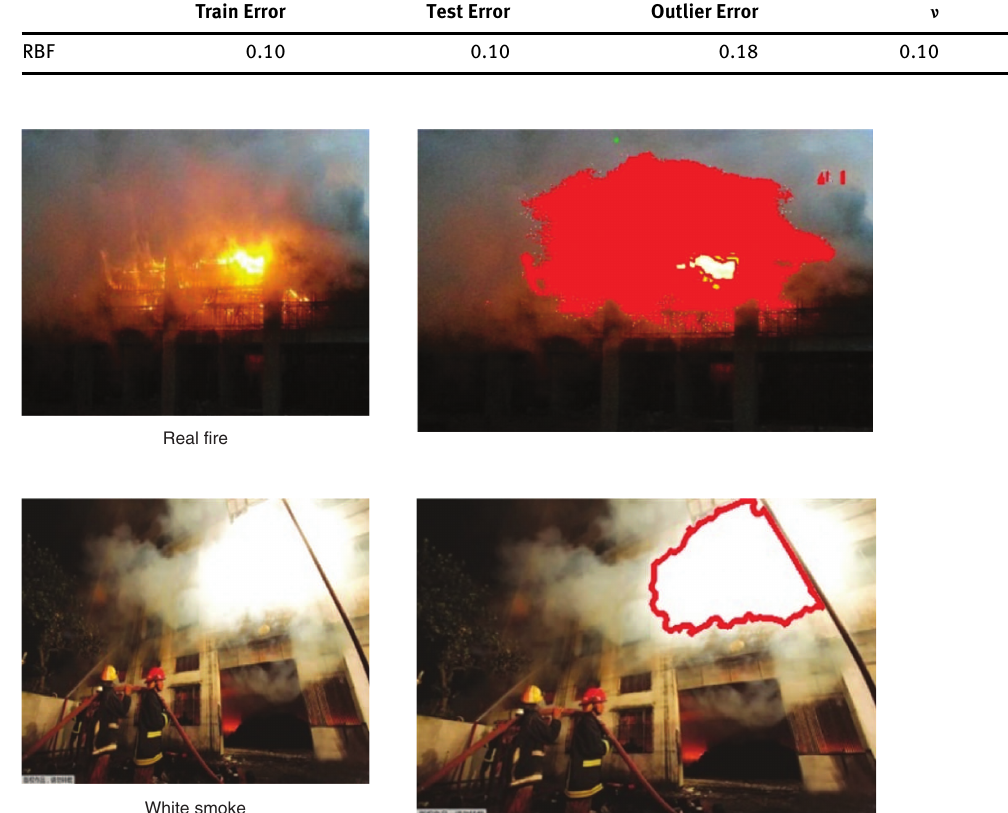
Figure 5: Candidate Region Generation Based on the SVM